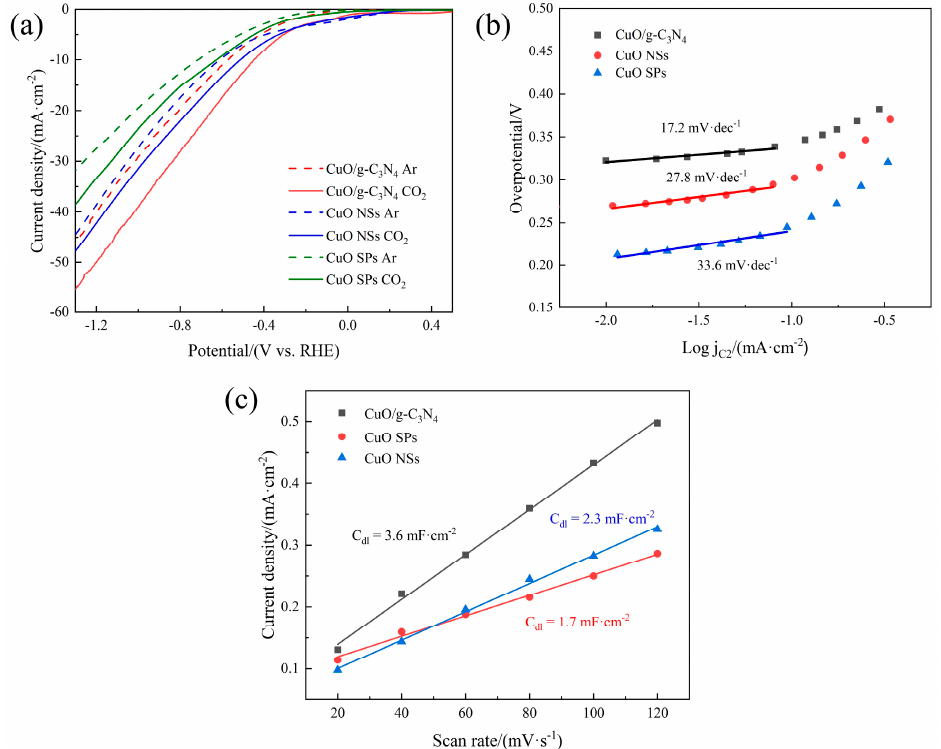
Figure 1. ( a ) LSV curves of CuO SPs, CuO NSs and CuO/g-C 3 N 4 in Ar- and CO 2 -saturated 0.1 M KHCO 3 solution, ( b ) Tafel slope calculation curves of CuO SPs, CuO NSs and CuO/g-C 3 N 4 , and ( c ) capacitive current at OCP as a function of the scan rate of CuO SPs, CuO NSs and CuO/g-C 3 N 4 in CO 2 -saturated KHCO 3 solution.